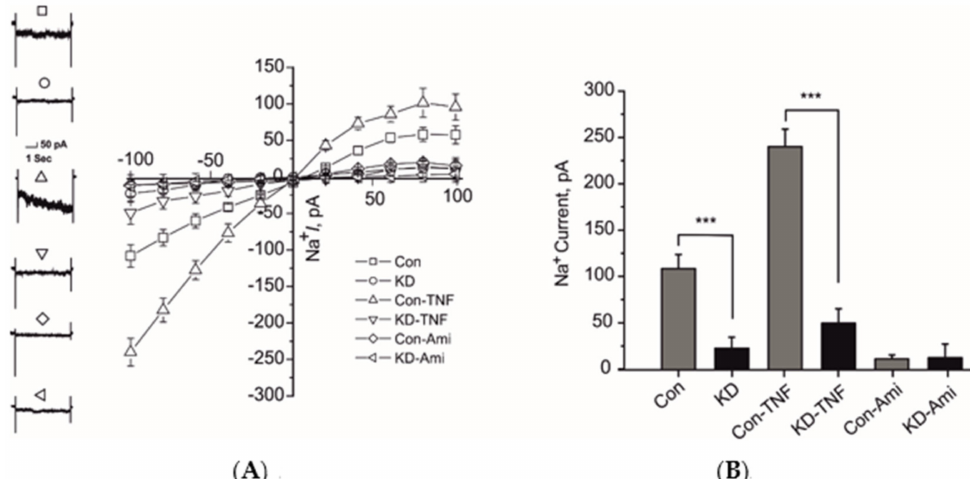
Figure 2. Knock down of δ -ENaC in A549 cells attenuated the tumor necrosis factor (TNF)-induced activation of ENaC. ( A ) Left panel, representative traces of whole-cell (10 µ M) amiloride-sensitive ENaC currents at 100 mV of indicated experimental settings are shown. Right panel, IV plots of whole-cell currents of indicated experimental settings are shown. ( B ) Mean values of whole-cell inward sodium currents at − 100 mV of indicated experimental settings are shown. Significant differences are indicated, *** p < 0.001, unpaired Student’s t -test, n = 12–15.